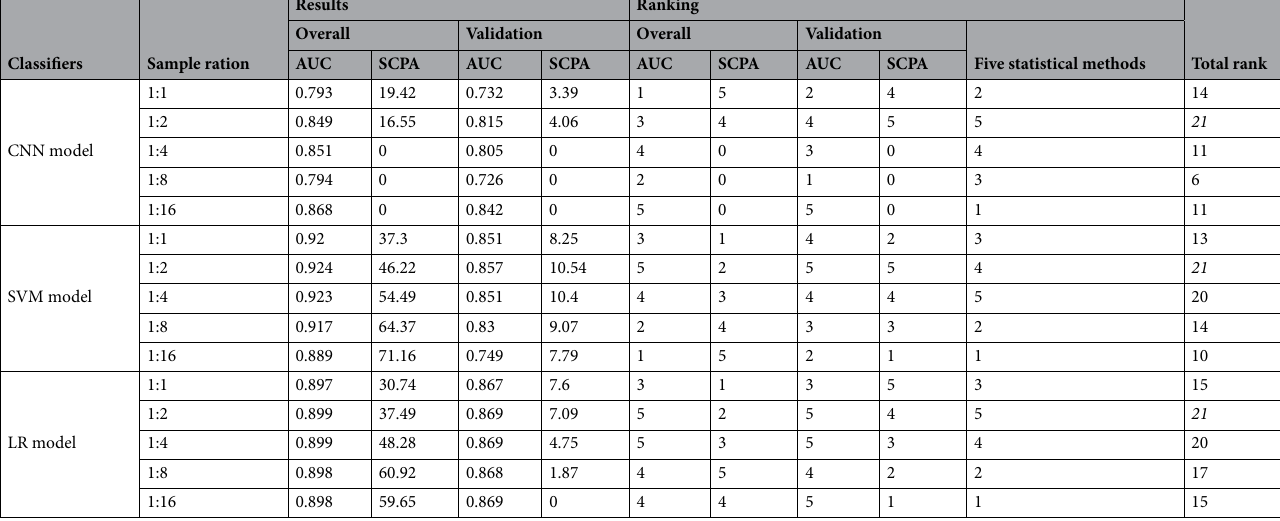
Table 10. Result of ranking system with different sample ratios. Significant values are in